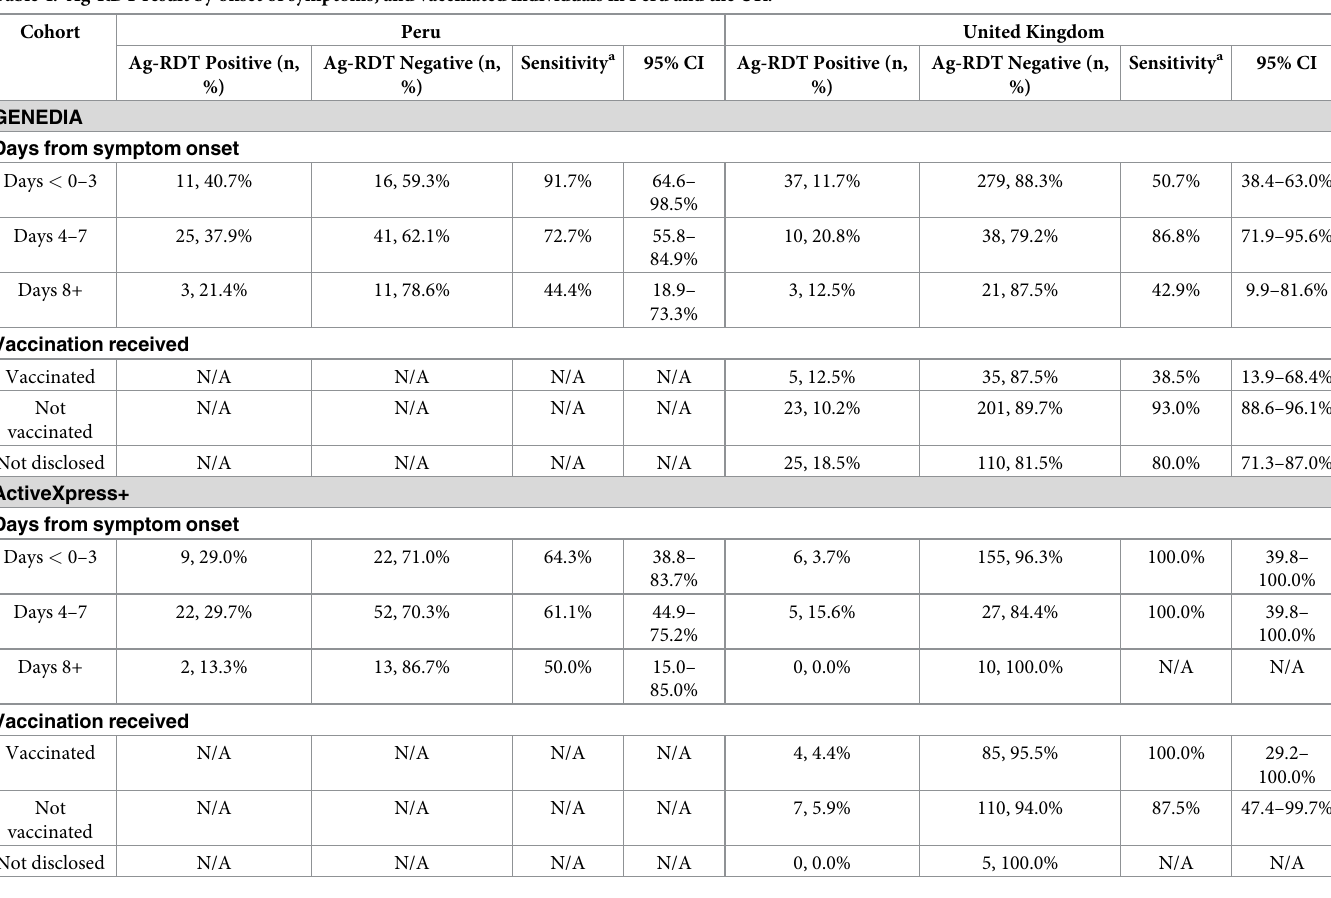
Table 4. Ag-RDT result by onset of symptoms, and vaccinated individuals in Peru and the